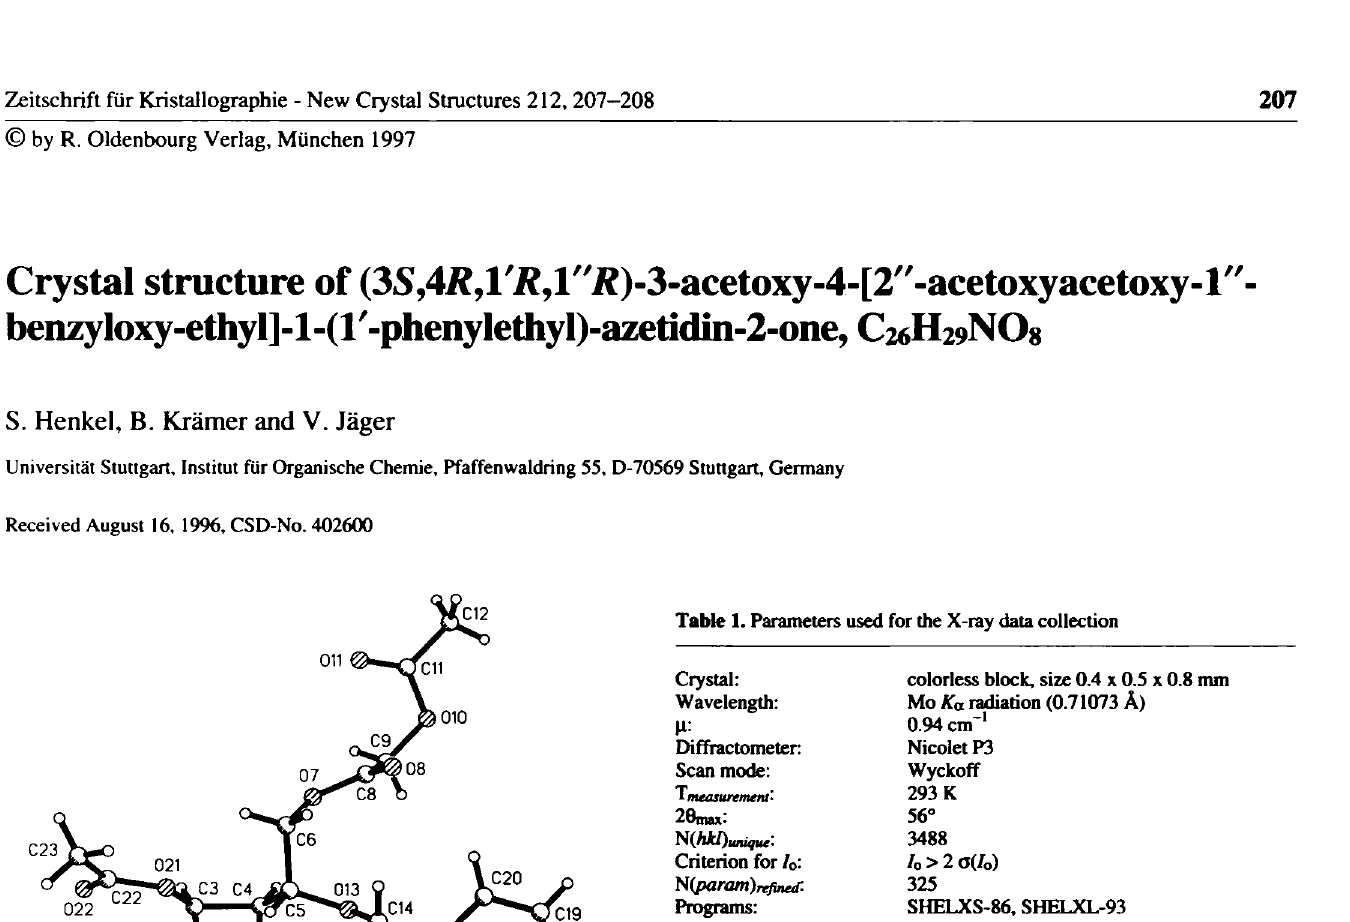
Table 2. Final atomic coordinates and displacement parameters (in À 2